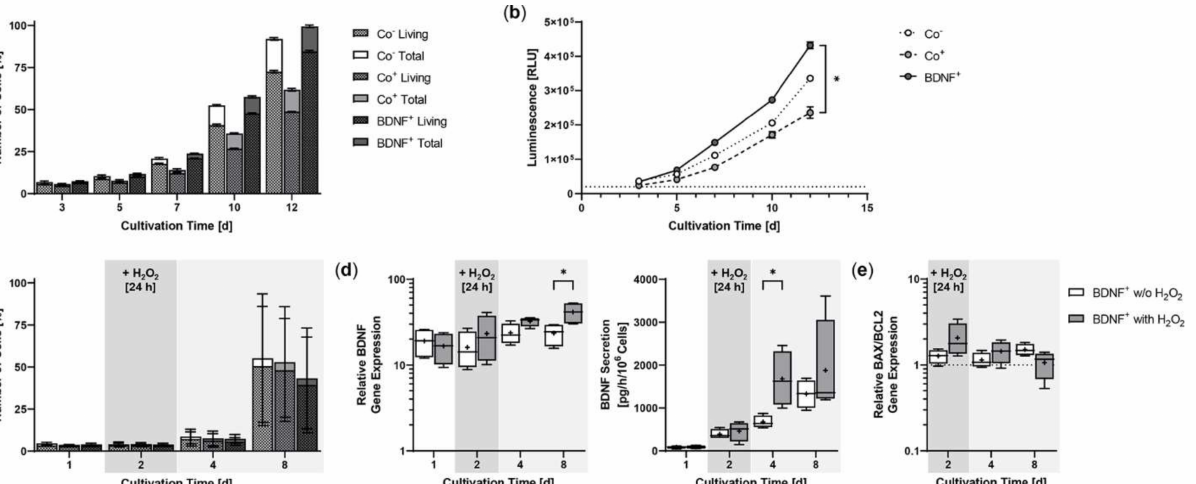
1324 ± 326.8 at day 8 for BDNF + cultures without H 2 O 2 and from 458.0 ± 226.7 pg/h/10 6 cells to 1672 ± 643.7 and 1875 ± 1155 for BDNF + cultures with H 2 O 2 , corresponding to 1.2-, 2.5-, and 1.4-fold higher BDNF secretion, respectively, for cultures after H 2 O 2 exposure (Figure 3d). ARPE-19 control cultures secreted an average of 23.65 ± 17.41 pg BDNF/h/10 6 cells (data not shown). H 2 O 2 treatment also altered the BAX / BCL2 expression ratio in the BDNF + cultures: immediately after treatment, it increased to 2.06 and was 1.6-fold higher than in the cultures without H 2 O 2 exposure. Subsequently, the BAX / BCL2 expression ratio decreased in the cultures with H 2 O 2 exposure (1.44 at day 4, 1.07 at day 8), whereas it increased in the cultures without H 2 O 2 exposure (1.14 at day 4, 1.51 at day 8, Figure 3e).